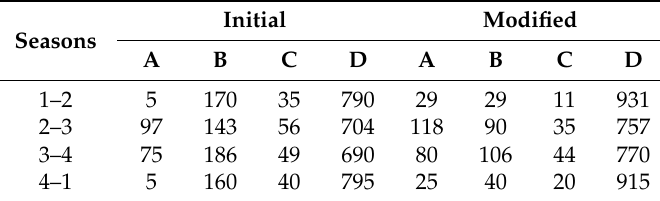
Table 5. Statistics by reference data and the results.